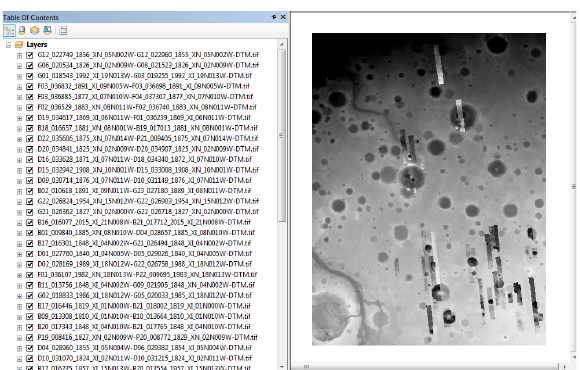
Figure 7. An overview of processed CTX DTMs superimposed on the MC-11E HRSC DTM mosaic (colour bar in local stretching).